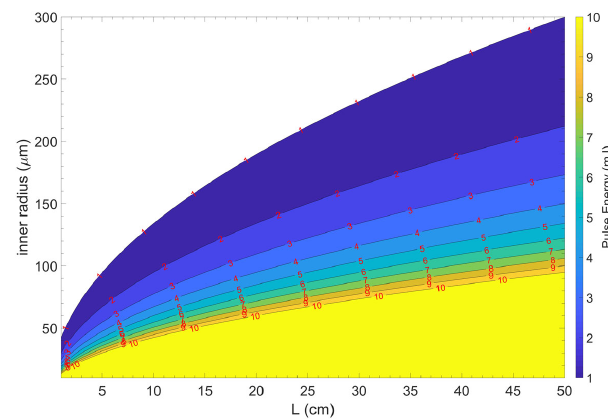
FIG. 6. Pulse energy dependence on a and L for a point charge of 100